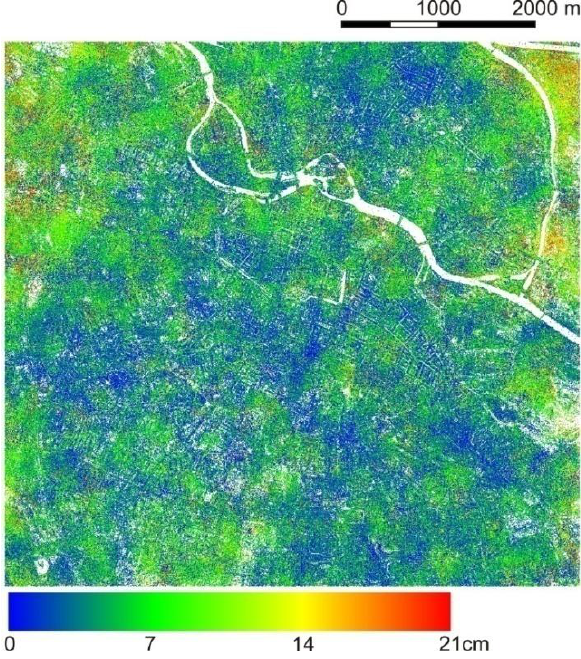
Figure 1. Map of spatial distribution of deviation in tie points height computed with and without Geometry Verified Matching in Pix4D (Wrocław dataset).